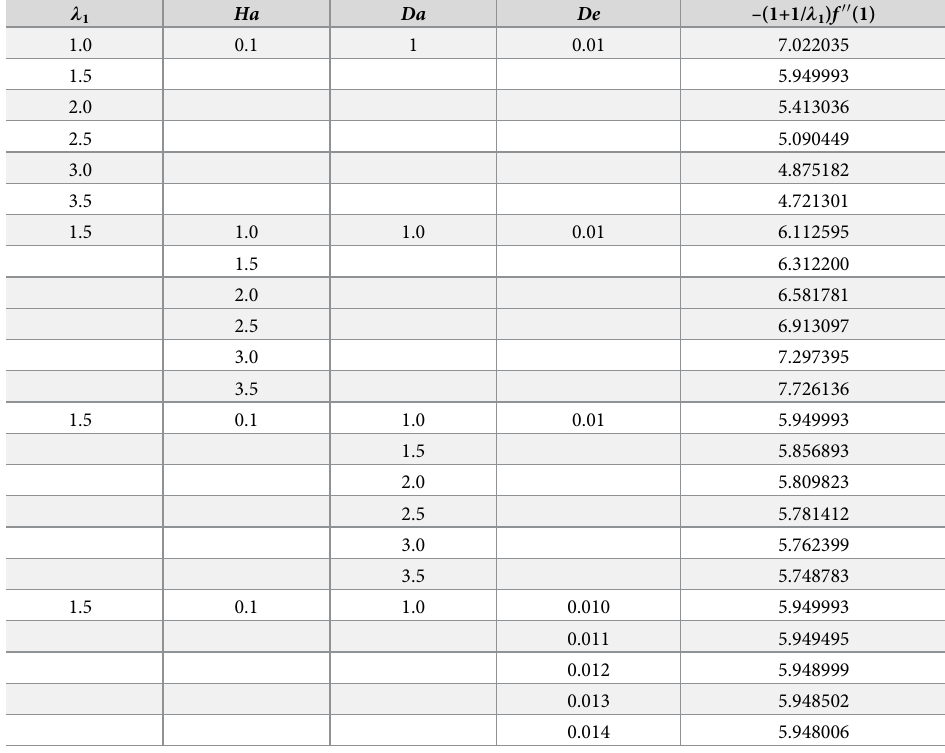
Table 5. Numerical outputs of –(1+1/ λ 1 ) f 00 (1) for λ 1 , Ha , Da and De when γ = 0.01, Ec = R d = N b = N t = 0.1, S = δ = 1 and Le = R = Pr =